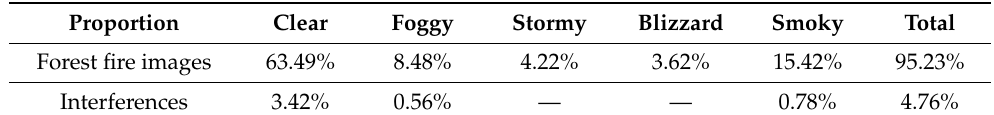
Table 1. Distribution and proportion of dataset.